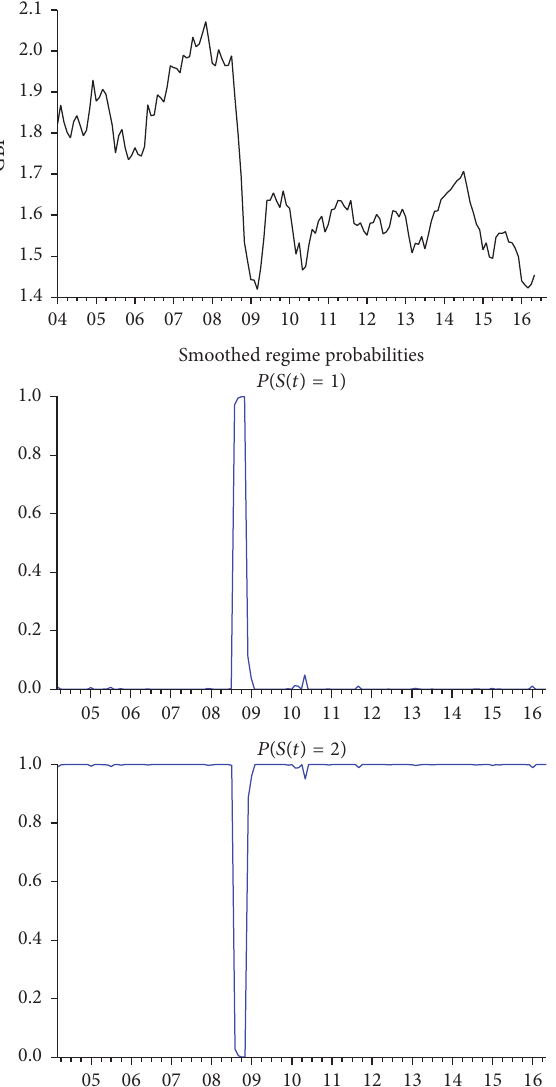
Figure 3: Time and smoothed probability plots of USD/EUR for 2004M01–2016M05.